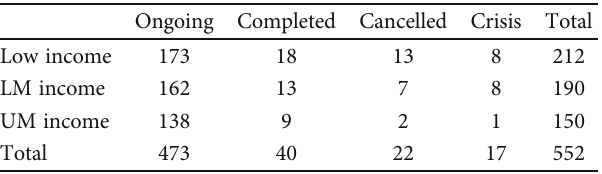
Table 2: The summary of the project status of the sampled Green PPP